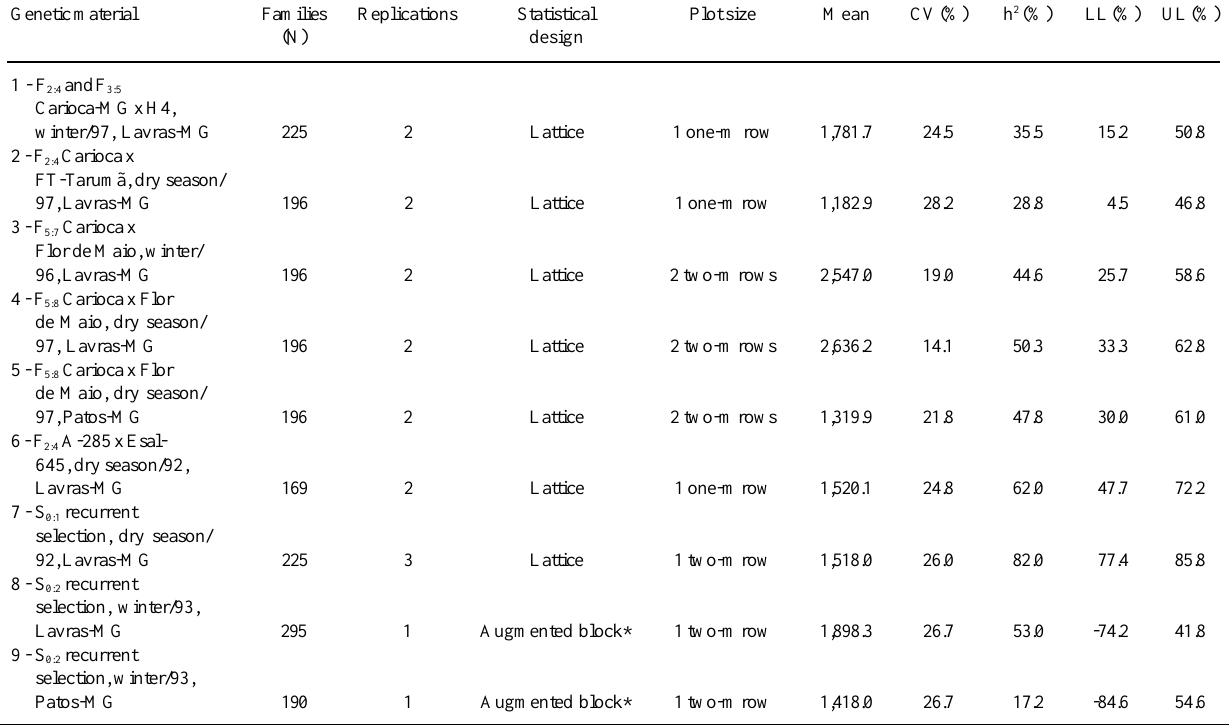
Table I - The genetic material, number of families, number of replications, statistical design, plot size, average grain yield, coefficient of variation (CV%), and heritability (h 2 ) estimates with upper (UL) and lower (LL) limits for common bean grain production (kg/ha). Genetic